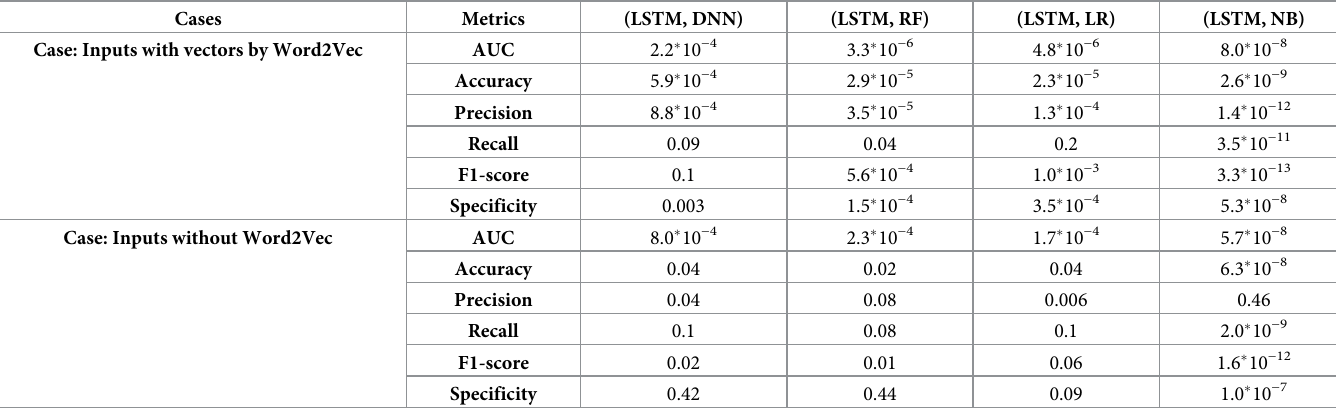
Table 5. Statistical significance of model comparison metrics.